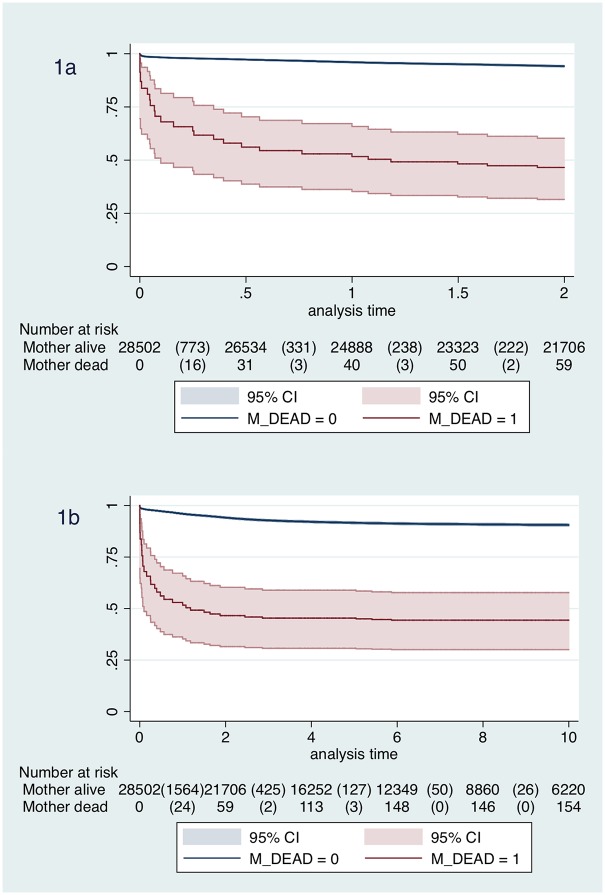
Kaplan-Meier survival estimates by maternal vital status for a) first 2-years, b) up to 10 years.